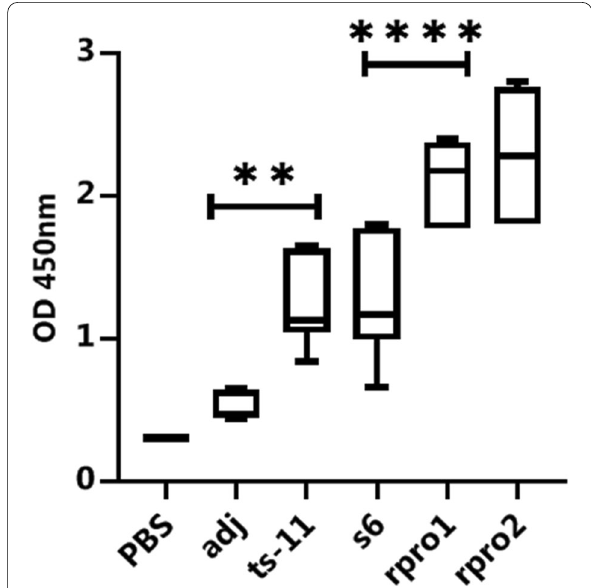
Fig. 5 Analysis of IgG antibodies induced by immunization determined by ELISA with recombinant protein in chicken. Numbers represent the mean optical density at 450 nm (OD 450) of serum samples collected at 42 days after immunization in each group. Statistical significance was determined by one-way ANOVA. **** P < 0.0001 indicated significant differences